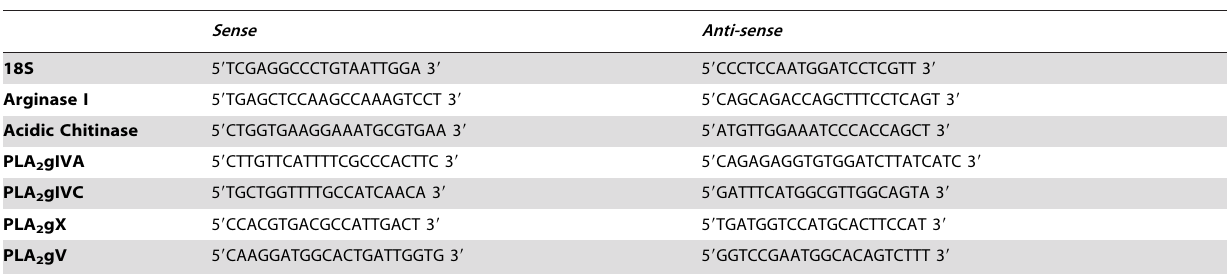
Table 1. Primers sets for